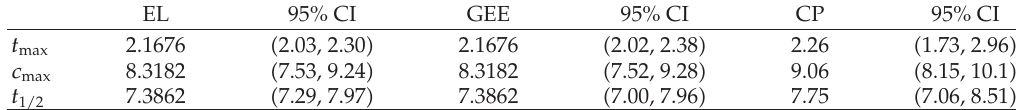
Table 2: Comparing parameter estimates for theophylline data in terms of accuracy and e ffi ciency. EL: empirical likelihood; GEE: general estimation equation; CP: compartment model.